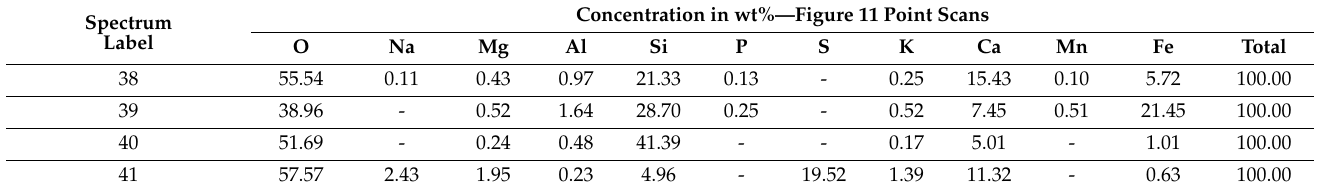
Figure 11. SEM–EDS scan on the surface of the red painting layer. Table 1. Elemental chemical compositions on the front of the painting layer are determined at four points shown in Figure 11.